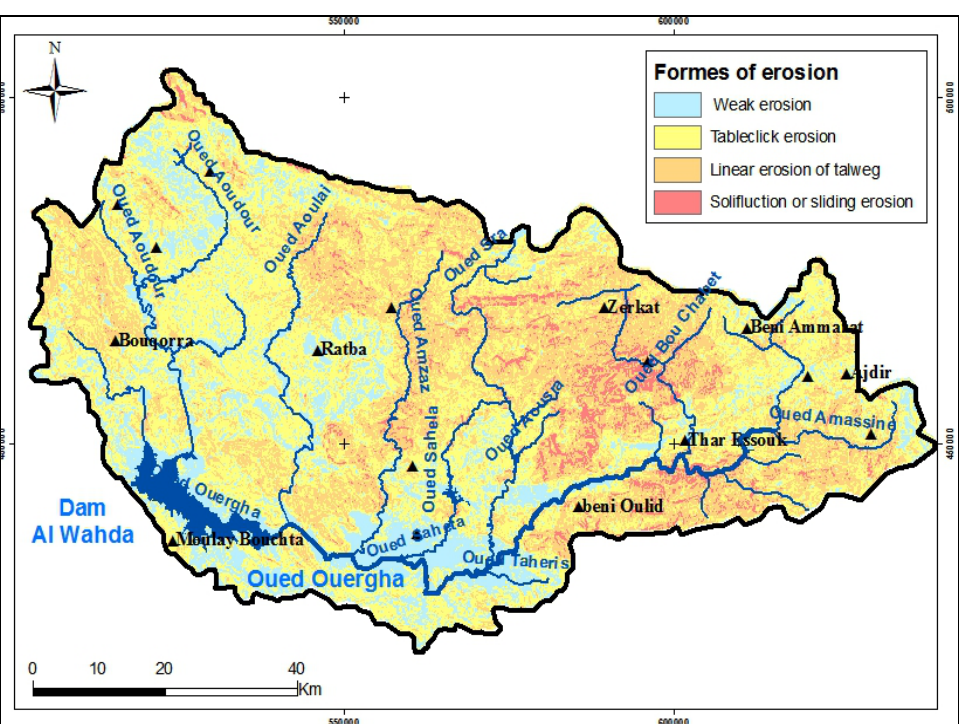
Figure 5 . Map of the main forms of water erosion The analysis of the soil loss map gives the map of the priority areas of the Oued Ouergha watershed (fig.6). The distribution of vulnerable zones shows a real spatial heterogeneity linked mainly to the typology of soils and to the socio-economic vulnerability that characterizes the Ouergha watershed.